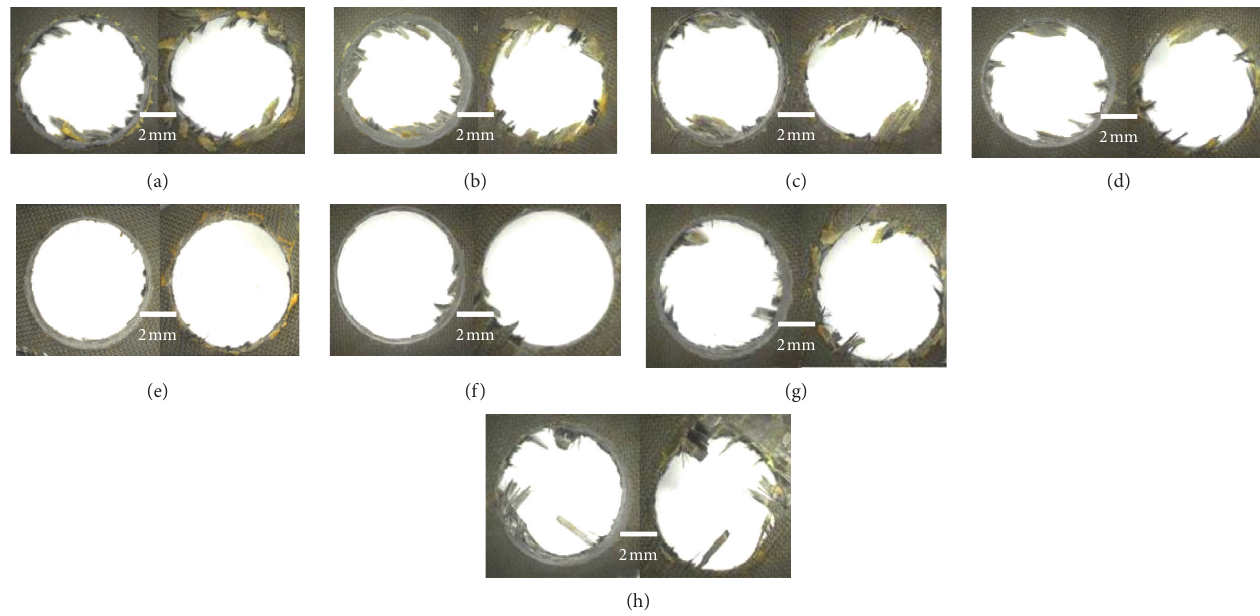
Figure 5: The photos of holes drilled by each drill. (a) 2 ϕ � 100 ° . (b) 2 ϕ � 110 ° . (c) 2 ϕ � 115 ° . (d) 2 ϕ � 120 ° . (e) 2 ϕ � 125 ° . (f) 2 ϕ � 130 ° . (g) 2 ϕ � 140 ° . (h) 2 ϕ � 150 ° .